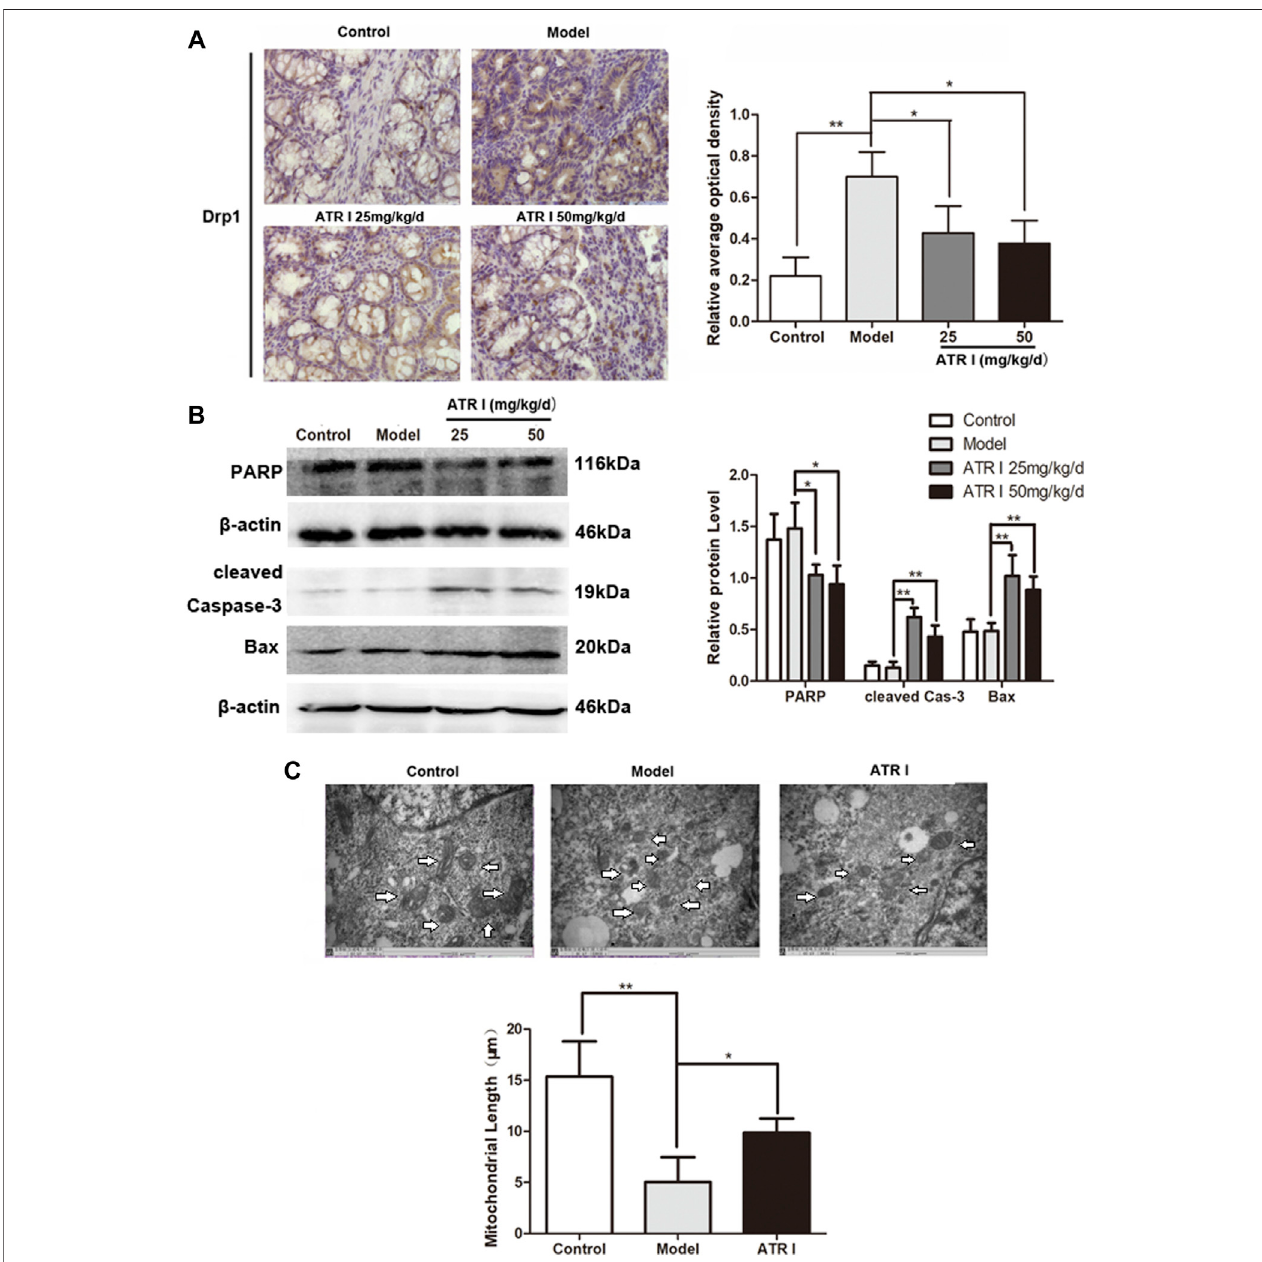
FIGURE5| AtractylenolideIinhibitsDrp1-mediatedmitochondrial fi ssionintheAOM/DSSmicemodel. (A) IHCofDrp1incolonictissuesection.Positivestainingis brown. (B) ExtractintestinaltissuelysateforWesternblotanalysisofPARP,cleavedcaspase-3,andBax(n (cid:2) 3pergroup).Thedensitometric analysisbardiagramofthe results. (C) TEM was applied to observe the morphology of the mitochondria. Mitochondrial length was representative of three independent experiments. * p < 0.05; ** p < 0.01, vs. model (mean ± S.D).